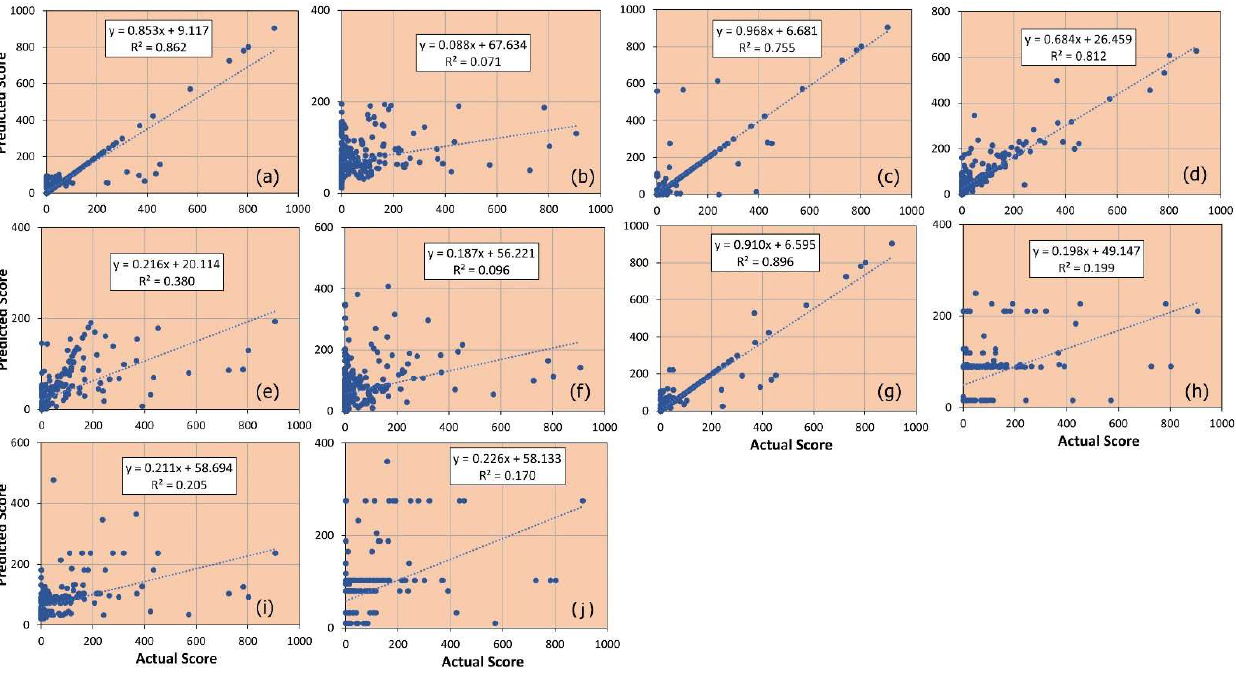
Figure A3. R 2 of the constructed machine learning models using the test dataset: ( a ) Gaussian Process Regression, ( b ) K-Nearest Neighbor, ( c ) Classification and Regression Trees, ( d ) Random Forest, ( e ) Support Vector Regression, ( f ) Multi-layer Perceptron Neural Network, ( g ) Extra Trees Regression, ( h ) AdaBoost, ( i ) Gradient Boosting, and ( j ) Histogram-Based Gradient Boosting.